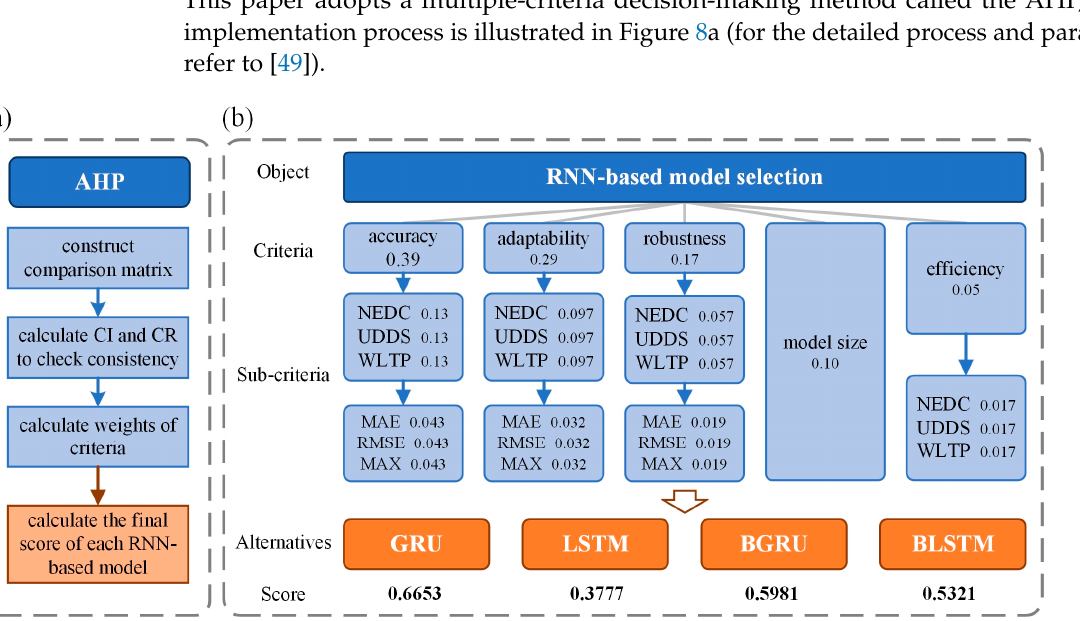
Figure 8. The framework of the AHP method: ( a ) AHP procedure; ( b ) weights of each level and final scores of four RNN-based models.